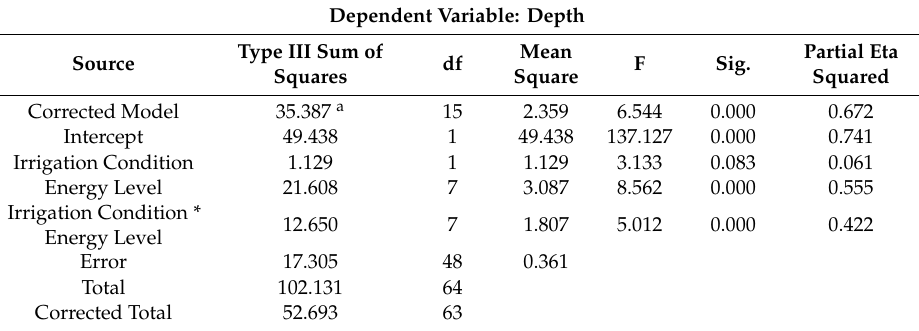
Table A2. Tests of Between-Subjects E ff ects.